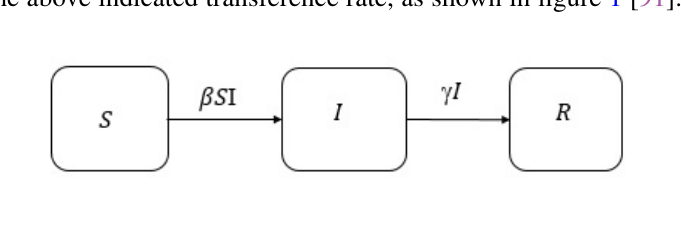
Fig. 1 Transfer diagram for an SIR compartment